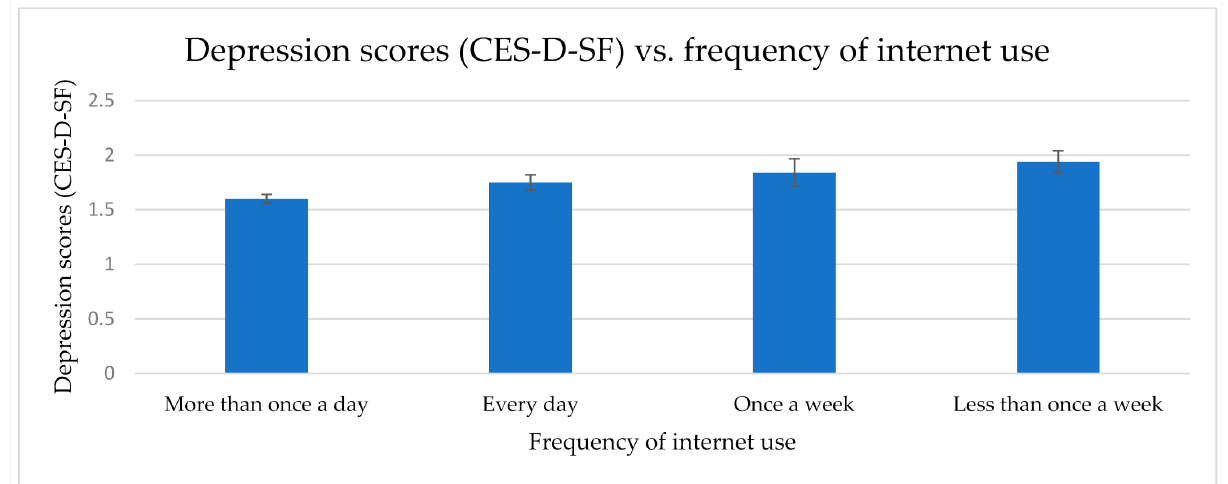
Figure 1. Mean depression scores (w/standard errors) vs. frequency of internet use. A significant main effect of frequency was observed ( p = 0.01), and there was a significant difference between the most and least frequent users ( p < 0.001).